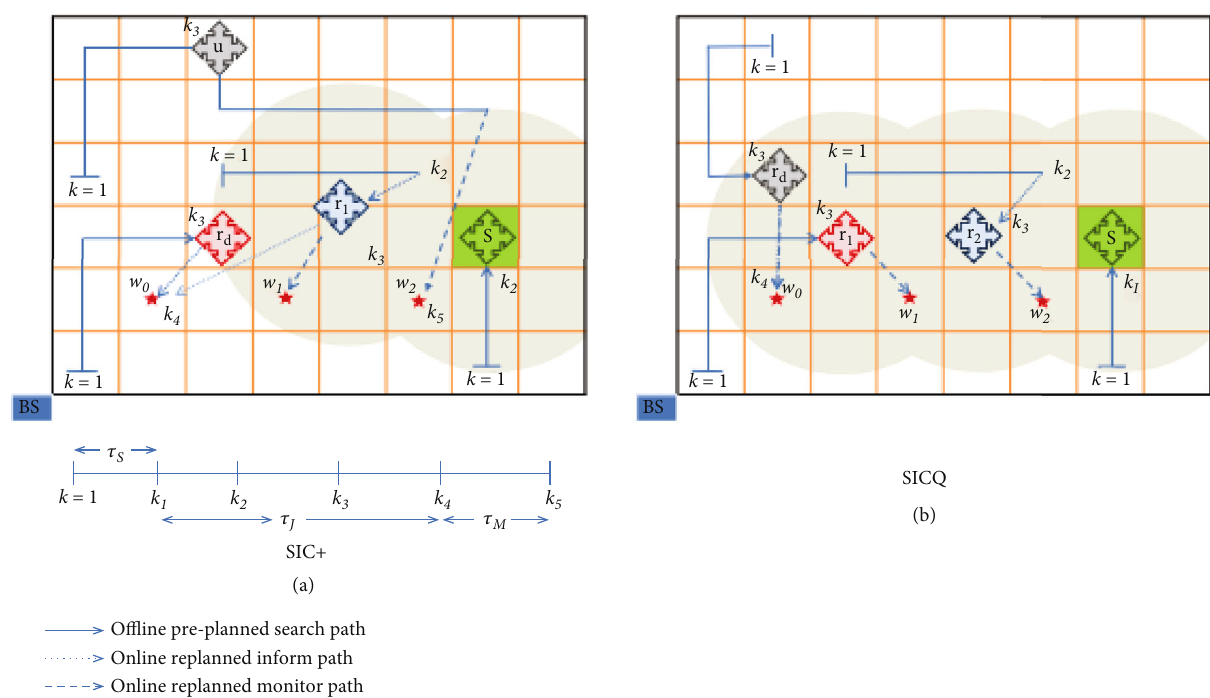
Figure 1: The structure of the two adaptive strategies